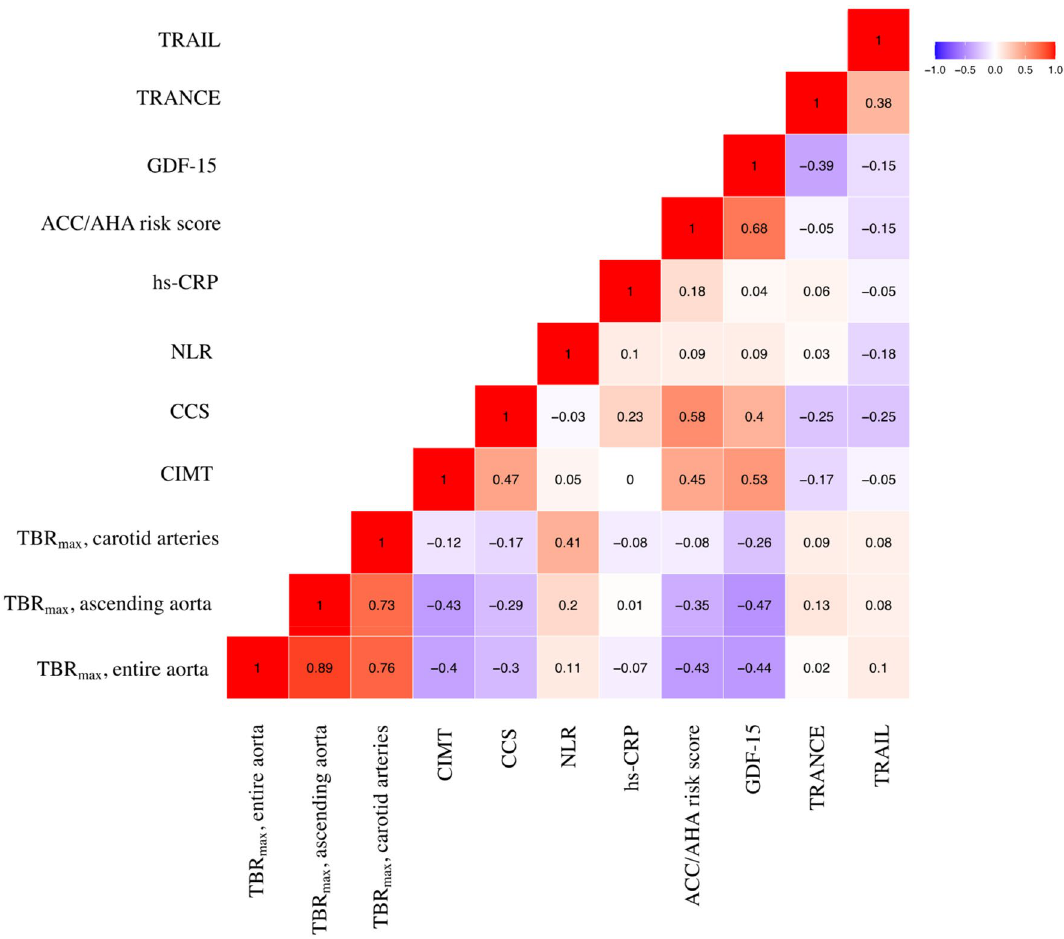
Figure 2. Correlation matrix with Pearson correlation coefficients between differentially expressed proteins, neutrophil-to-lymphocyte ratio (NLR), high-sensitive C-reactive protein (hs-CRP), America College of Cardiology/American Heart Association (ACC/AHA) risk score and markers of subclinical atherosclerosis in patients with psoriasis without cardiovascular disease and statin treatment (n = 36). TRAIL tumor necrosis factor-related apoptosis inducing ligand, TRANCE tumor necrosis factor-related activation-induced cytokine, GDF-15 growth differentiation factor-15, CCS coronary artery calcium score, CIMT carotid intima-media thickness, TBR max maximum target-to-background